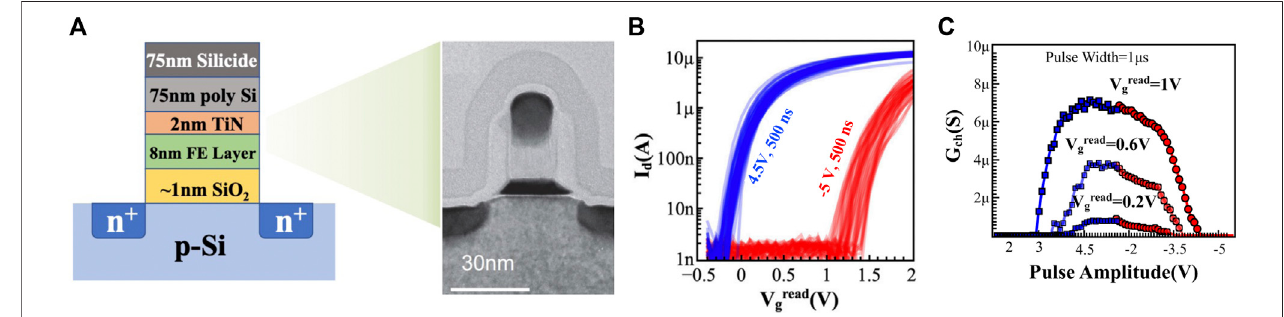
FIGURE 2 | (A) Schematic illustration with the transmission electron micrograph of the FeFET cell fabricated in the GlobalFoundries ’ 28-nm HKMG facility. (B) Program- – eraseoperationconductedacrosssixtytestdevicesusing1 µspulseofamplitude ± 5 V. (C) Analogprogram – eraseoperationsinasingleFeFETcellshowthe impact of V gread on the number of different states and linearity (Soliman et al., 2020; Lederer et al.,